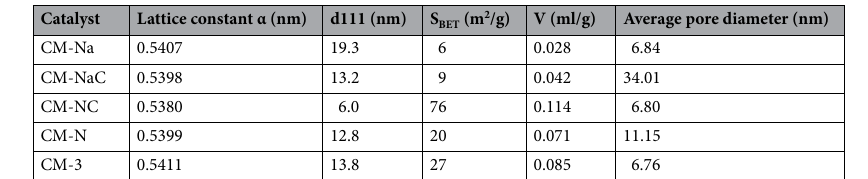
Table 1. Structural and textural properties of cerium manganese